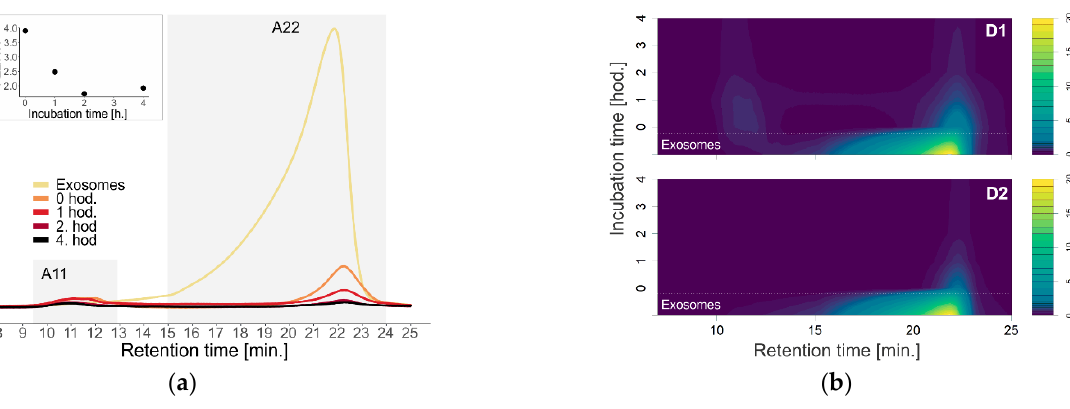
Figure 4. ( a ) Absorption chromatograms of urinary exosomes depending on the time of incubation of added dendrons with exosomes at temperature of 37 °C. The nested graph shows the ratio of absorbance (A) at a retention time of 11 and 22 min as a function of incubation time at temperature of 37 °C. ( b ) Contour plots of exosome absorbance at different incubation times of dendrons with exosomes, top—first-generation dendron; bottom—second-generation dendron.